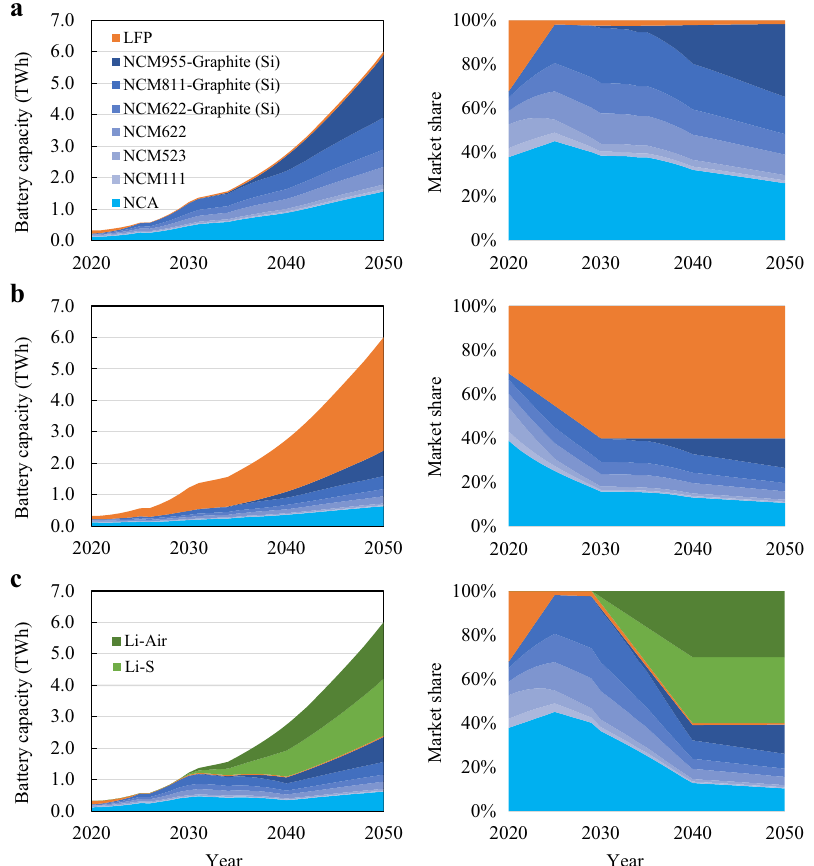
Fig. 2 Battery market shares and yearly EV battery sales until 2050 for the fl eet development in the STEP scenario. a NCX scenario. b LFP scenario. c Li-S/Air scenario. See Supplementary Fig. 4 for the Sustainable Development scenario. See Supplementary Fig. 5 for battery sales in units. LFP lithium iron phosphate battery, NCM lithium nickel cobalt manganese battery, Numbers in NCM111, NCM523, NCM622, NCM811, and NCM955 denote ratios of nickel, cobalt, and manganese. NCA lithium nickel cobalt aluminum battery, Graphite (Si) graphite anode with some fraction of silicon, Li-S lithium-sulphur battery, Li-Air lithium-air battery, TWh 10 9